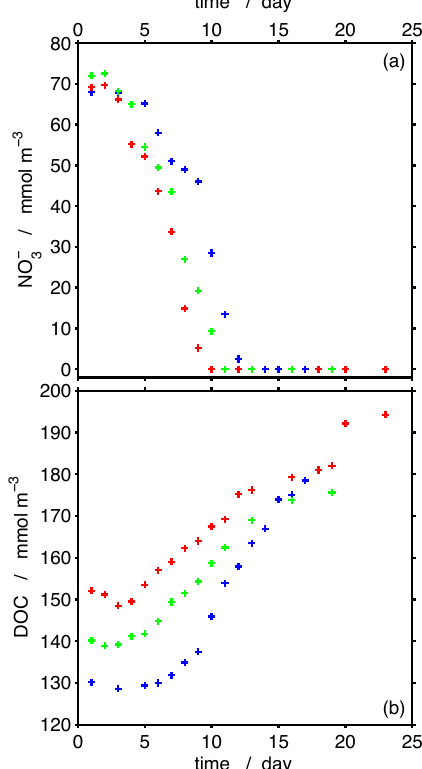
Fig. 2. Time course of 1f CO 2 (a) and 1 [CO 2 − ] (b) during phy- 3 toplankton culture experiments. Colour code as in Fig. 1. 1f CO 2 and 1 [CO 2 − ] are computed as follows: 1f CO 2 =( f CO 2 (C 3 T , pH )